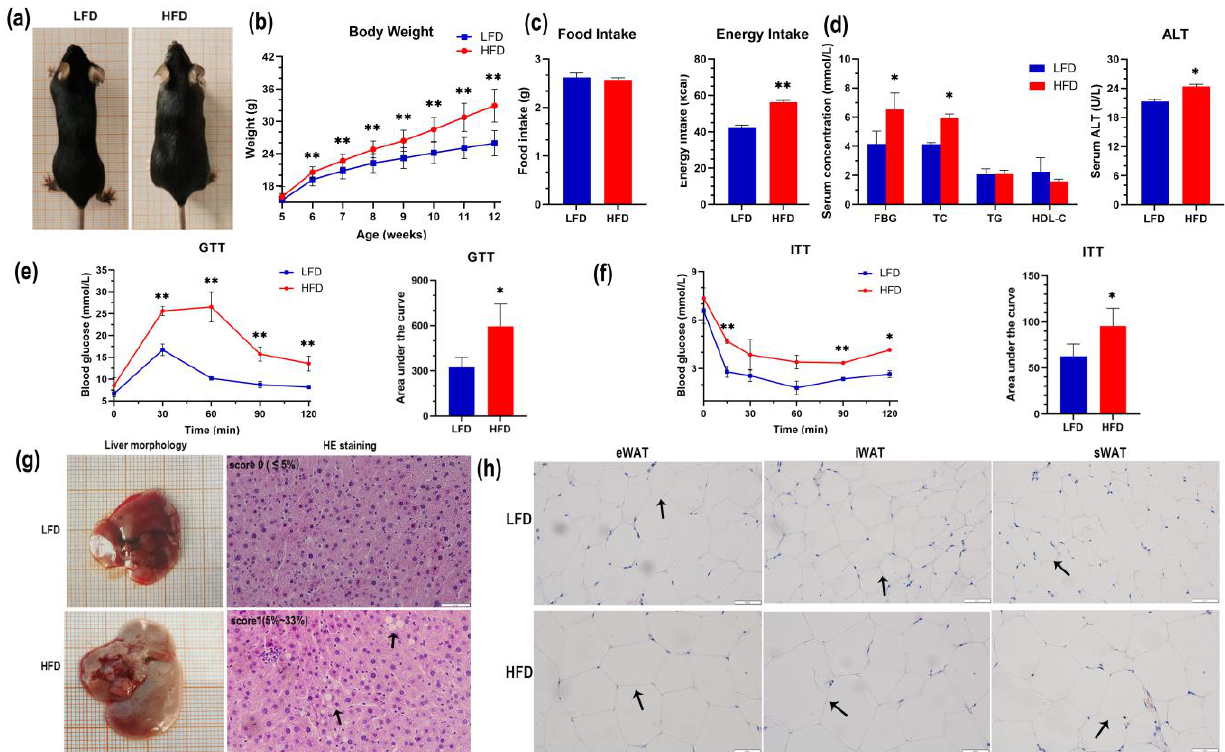
Figure 1. Establishment of a mouse model of diet-induced obesity. ( a ) The appearance of HFD and LFD mice; ( b ) Average weekly body weight of HFD- and LFD-fed mice; ( c ) average daily food intake and energy intake per mouse. Average energy intake per mouse in the HFD or LFD group = different feed energy × average daily food intake per mouse. HFD: 21.92 kJ/g, LFD: 16.11 kJ/g; ( d ) serum concentration of FBG, TC, TG, HDL-C, and ALT between the HFD and LFD groups; ( e ) results of GTT and AUC of GTT ( f ) results of ITT and AUC of ITT; ( g ) liver morphology and HE staining of the liver (arrows point to fat vacuoles); the hepatic steatosis score of HFD mice = 1 (5%~33%), × 200 microscope magnification (scale bar, 50 μm); ( h ) HE staining of adipose tissue (arrows show changes in the number and size of adipocytes), eWAT: epididymis white adipose tissue, iWAT: inguinal white adipose tissue, sWAT: subcutaneous adipose tissue, × 400 microscope magnification (scale bar, 50 μm) . * p < 0.05, ** p < 0.01.